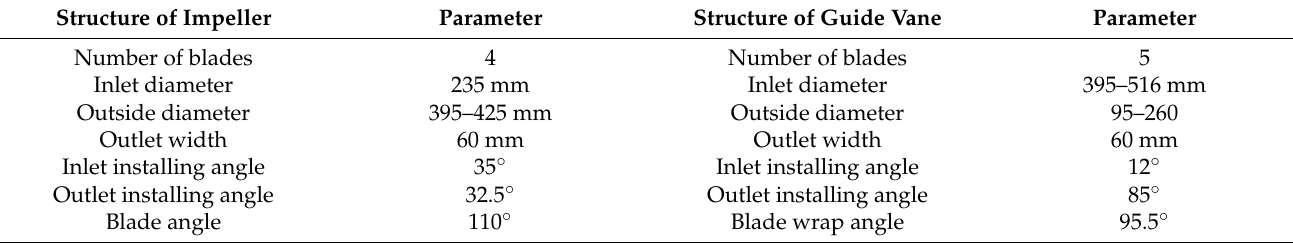
Table 1. Main design parameters of the impeller.